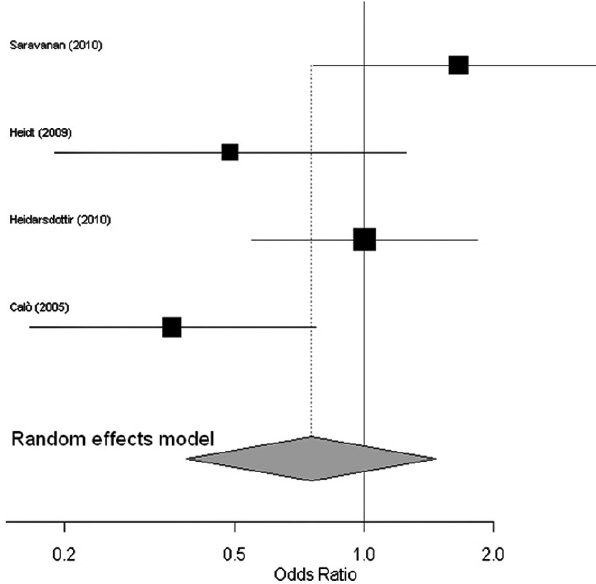
Figure 2 - A meta-analysis of the randomized studies examining the incidence of postoperative